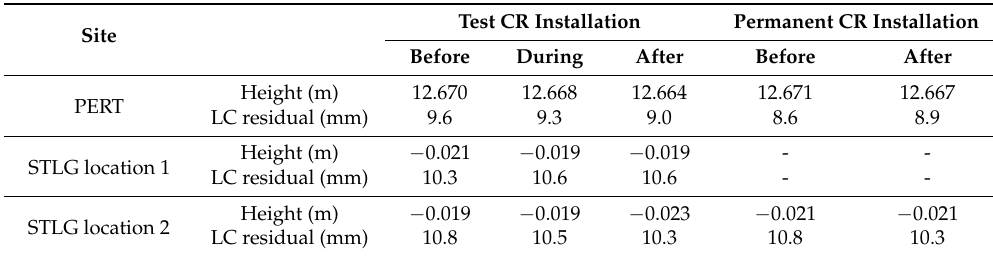
Table 4. Comparison of the GPS-only average of the daily RMS of the carrier-phase (LC) residuals (mm) measured over different time periods directly before and directly after permanent corner reflector (CR) installations. The dates of the permanent installations are given in Table 2.